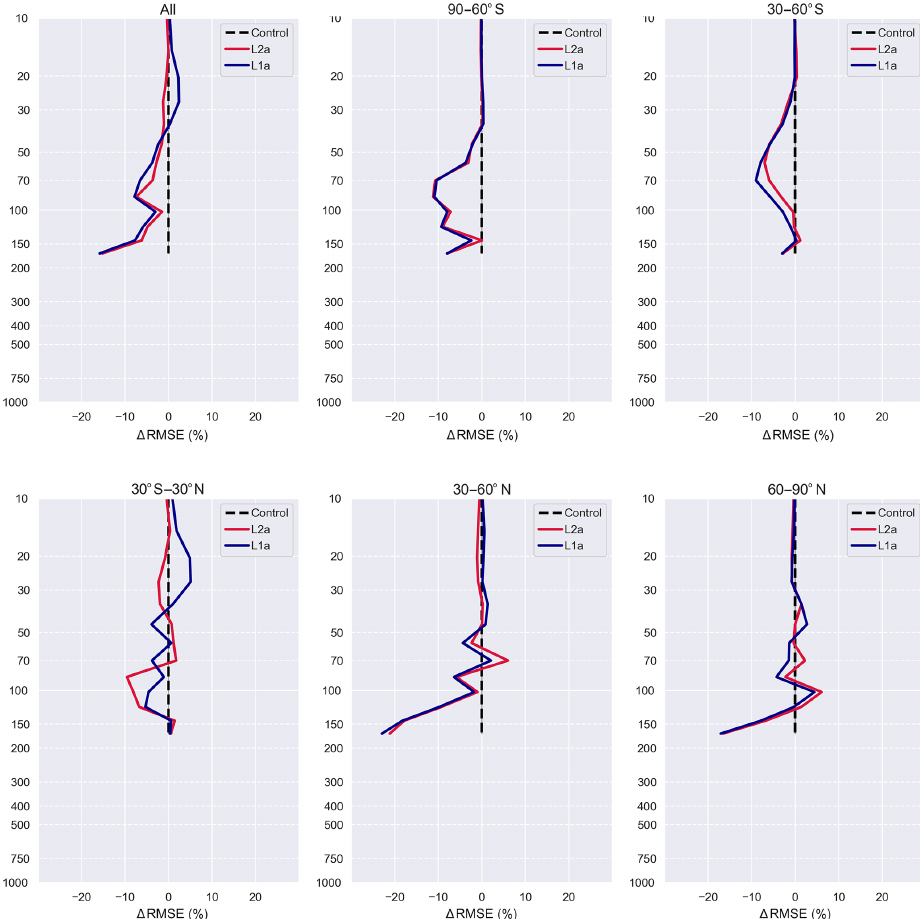
Figure 10. Relative difference of RMSE ( (cid:49) RMSE) with respect to MLS profiles for L1a (blue) and L2a (red). Same plots as in Fig. 9.